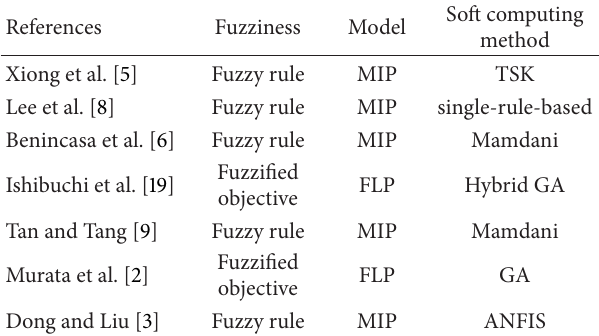
Table 1: Some fuzzy scheduling